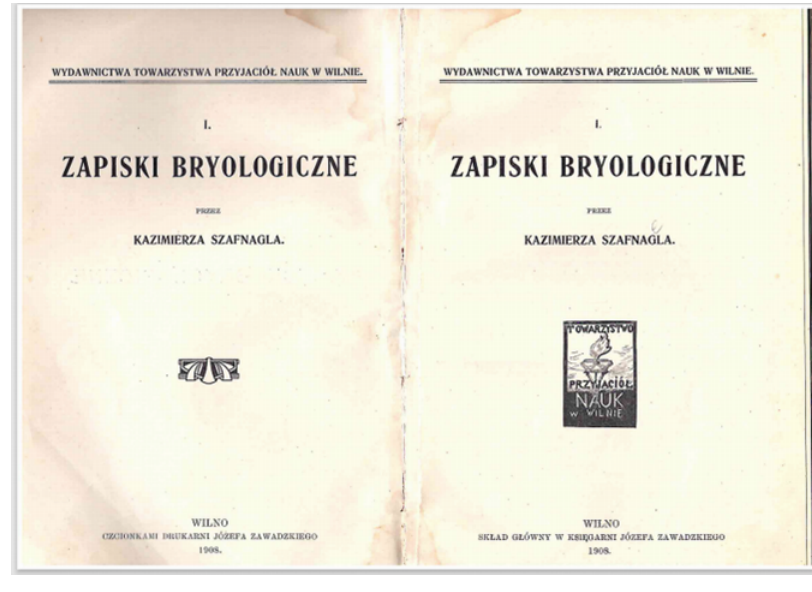
Figure 1 Title pages of Zapiski bryologiczne.